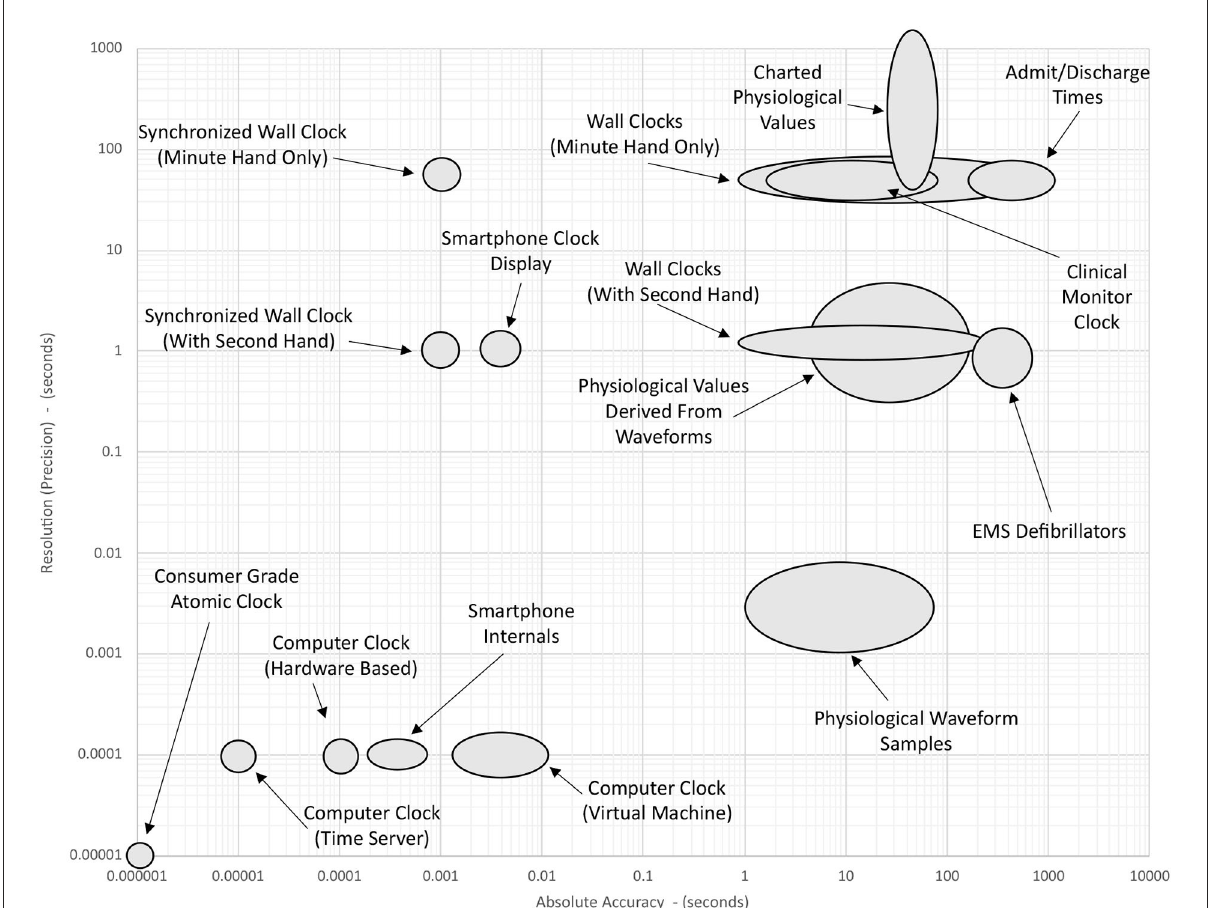
FIGURE2 Approximate accuracy and resolution of different time sources in the ICU. Positions of the ellipses are determined by the summation of factors discussed in the literature cited in Sections 1–4. The position of a device shown in this figure indicates its approximate precision and accuracy before any of the timekeeping improvements described in Section 6 have been